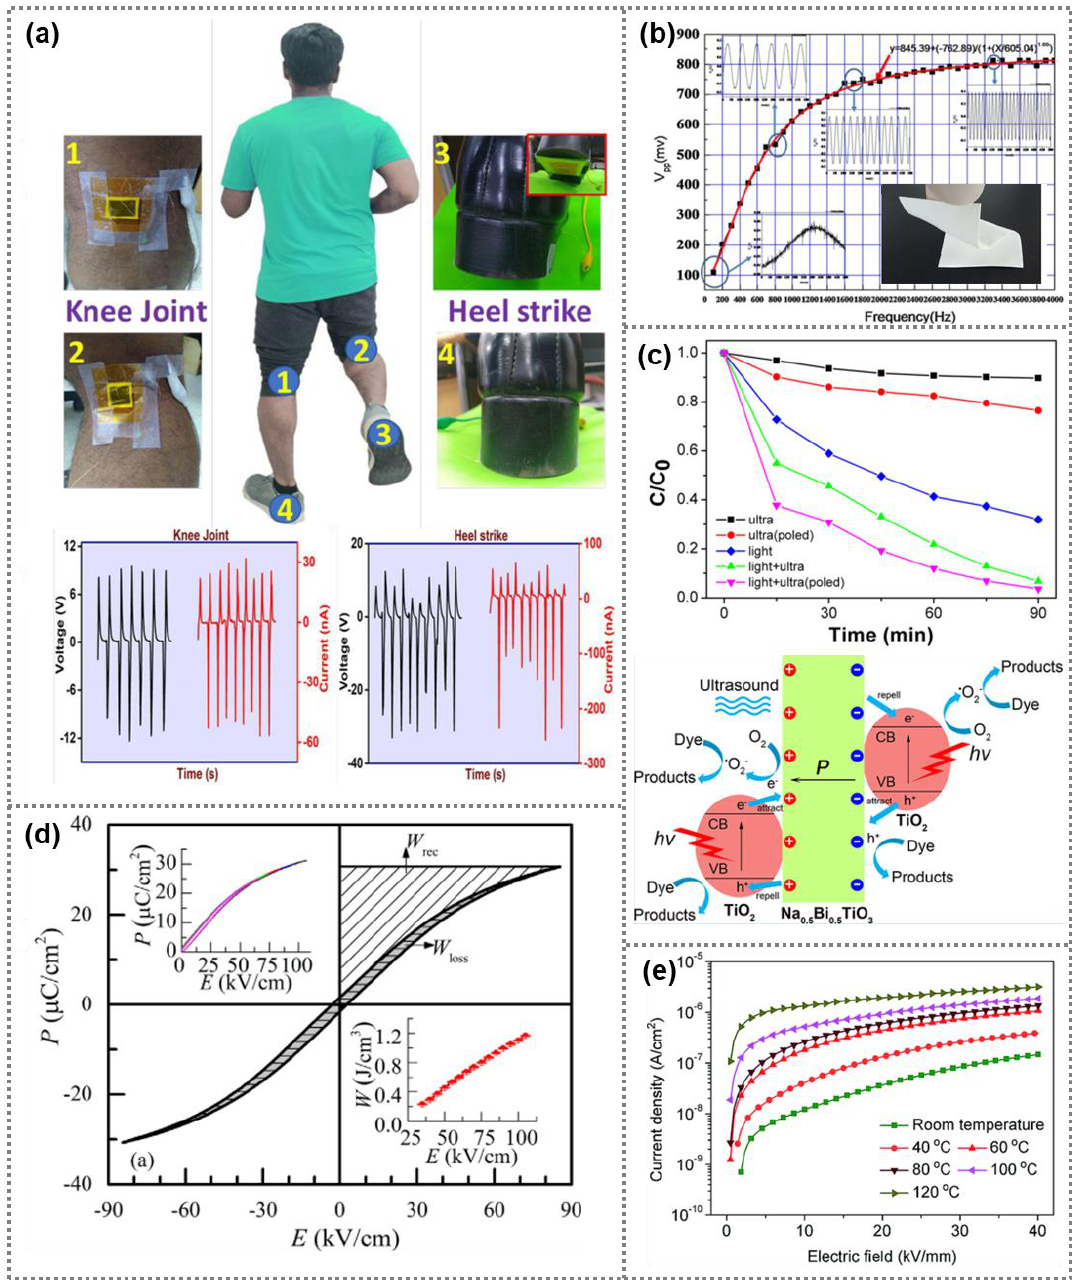
Figure 6. Applications of BNT ferroelectric nanomaterials. ( a ) Wearable piezoelectric nanogenerator based on BNT nanoparticles (Reproduced with permission from [105], RSC advances, 2020). ( b ) Frequency sensor based on flexible (0.78BNT-0.22ST)/PVDF composite membranes (Reproduced with permission from [47], Elsevier, 2016). ( c ) Degradation rate of RhB dye solution by using BNT@TiO 2 heterojunction composite catalyst, and the mechanism of piezo-photocatalytic degradation of RhB by BNT@TiO 2 nanowire with heterojunction (Reproduced with permission from [40], American Chemical Society, 2020). ( d ) Performance of (0.94 – x)Bi 0.5 Na 0.5 TiO 3 -0.06BaTiO 3 -xSrTi 0.875 Nb 0.1 O 3 nanomaterials-based capacitors (Reproduced with permission from [107], Elsevier, 2016). ( e ) Leakage current of capacitors based on BNT/P(VDF-HFP) composite membranes (Reproduced with permission from [44], RSC advances, 2020).